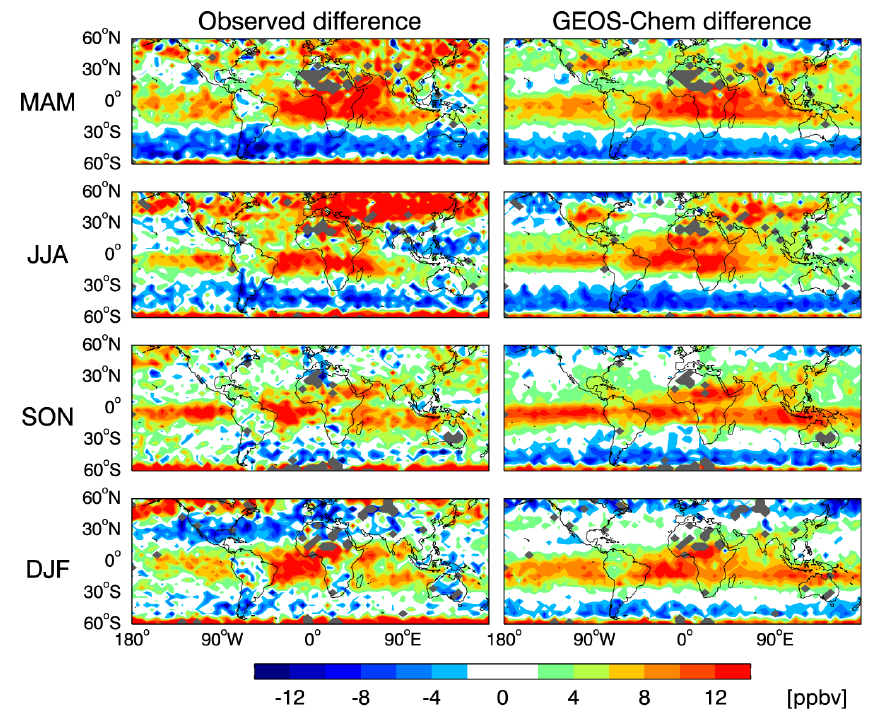
Fig. 4. Mean TES minus OMI differences in ozone concentrations (ppbv) at 500hPa for the four seasons of 2006. The left panels show the observed differences. The right panels show the differences attributable solely to instrument sensitivity, as indicated by results from a GEOS-Chem simulation smoothed with TES vs. OMI averaging kernels. Positive values (red colors) indicate that TES is higher than OMI, and negative values (blue colors) indicate that TES is lower than OMI. Gray areas indicate lack of data meeting the retrieval quality